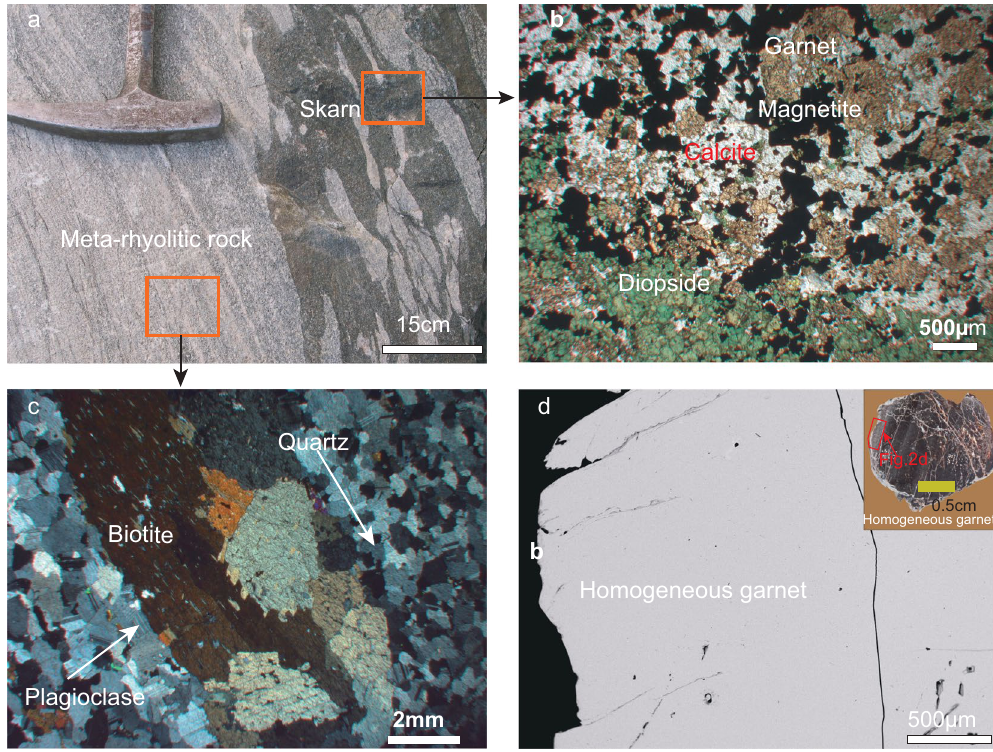
Figure 2. ( a ) The reaction relic texture of hydrothermal fluids and the hosting meta-rhyolitic volcanoclastic rocks. ( b ) typical skarn mineralization with garnet + diopside + magnetite + calcite. ( c ) shows orthogonal light plagioclase as polysynthetic twin. Quartz is recrystallized with elongated biotite. ( d ) Backscattered electron image of a homogenous garnet crystal. The BSE image location is marked in the